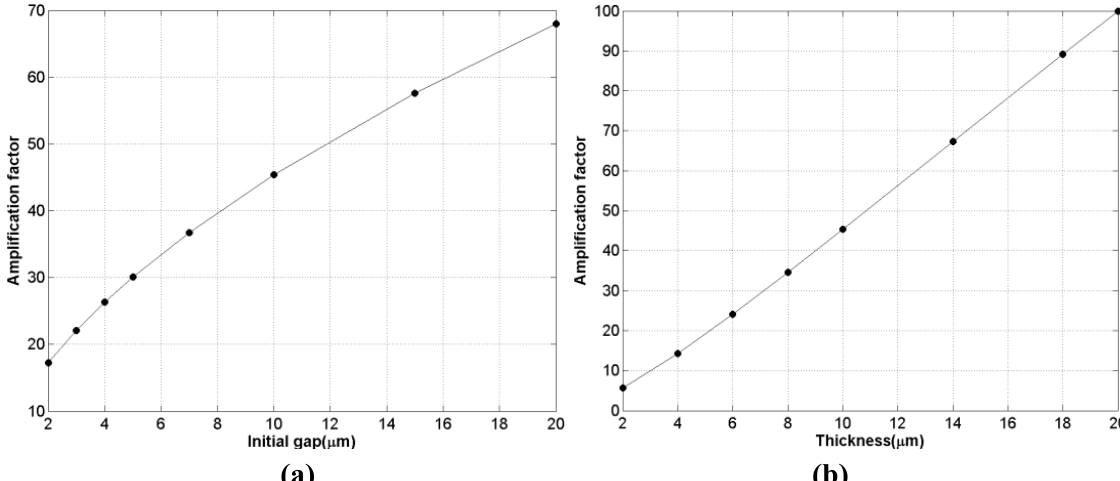
Figure 3. The relationship between ampli fi cation factor and the geometric parameters of proposed microcantilever sensor. The applied force is equal to 1 nN and the reference microcantilever data has been used for simulation. The excitation voltage is 1 mV below the pull-in